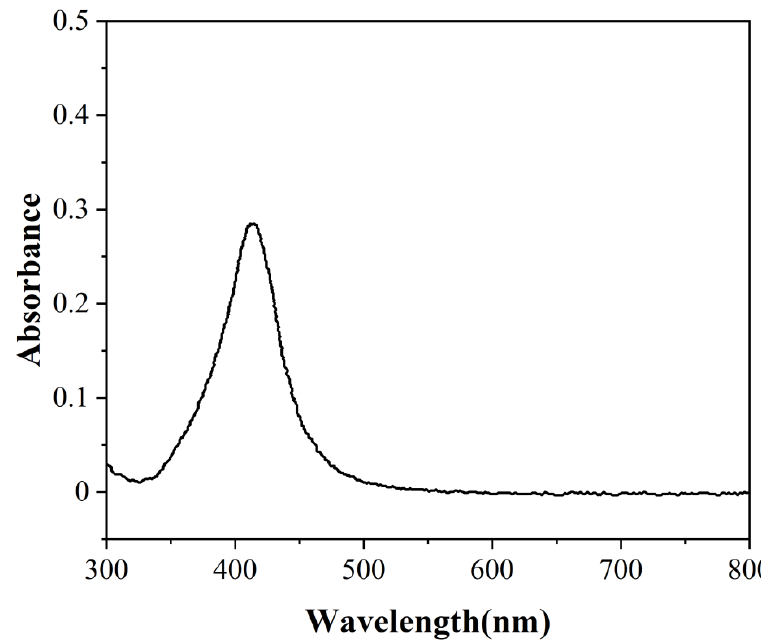
Figure 14. The absorbance of mixed nanofluids after flushing under the focused sunlight. ticles with vapor, the nanofluids were heated with resistance wires. Figure 15 shows the previous concentration calculation method, the concentration of nanofluids before dilution was 20.58 ppm with a power of 16.2 W, and the concentration of nanofluids before dilution was 31.39 ppm with a power of 20 W. It showed that more Ag nanoparticles migrated with vapor with increasing power. The reason was that the higher heating power reduc- tion caused nanofluids to boil more violently in the tube, leading to more nanoparticles detaching from nanofluids with vapor generated by the boiling.